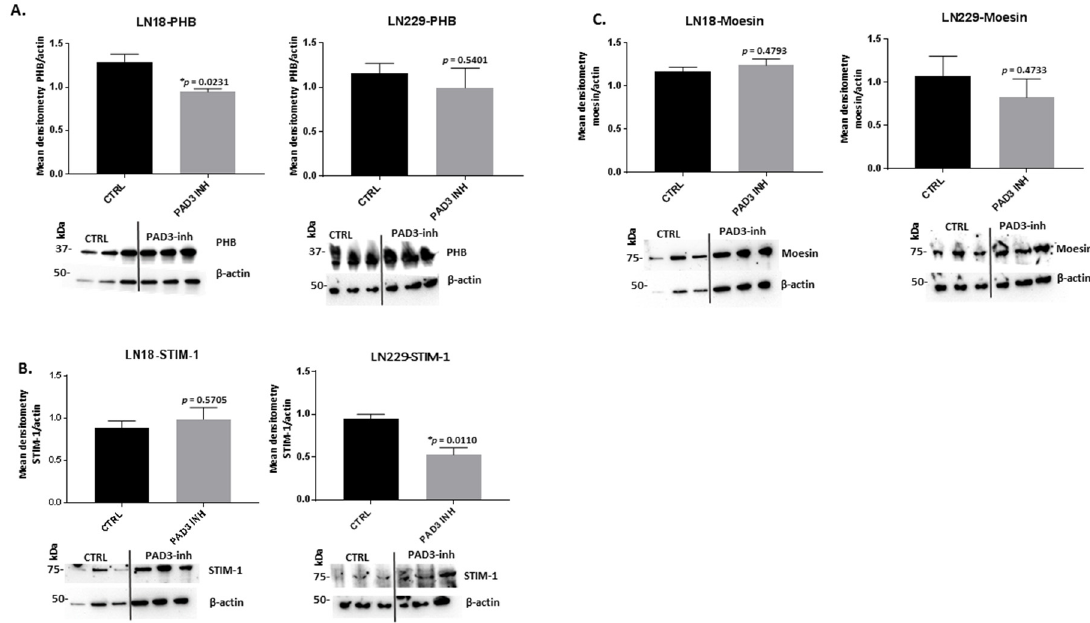
Figure 6. PAD3 isozyme-specific inhibitor 1 h treatment affects PHB, STIM-1 and moesin protein levels in two GBM cell lines. ( A ) PHB protein levels in LN18 and LN229 cells, respectively, following 1 h treatment with the PAD3 inhibitor, compared to control-treated cells. ( B ) STIM-1 protein levels in LN18 and LN229 cells, respectively, following 1 h treatment with the PAD3 inhibitor, compared to control-treated cells. ( C ) Moesin protein levels in LN18 and LN229 cells, respectively, following 1 h treatment with the PAD3 inhibitor, compared to control-treated cells. Representative blots are shown; the density ratios of the various proteins analysed and actin are presented as normalised quantified data (mean ±S.D.) for treatment with the PAD3 specific inhibitor, compared to DMSO treated controls. The corresponding molecular weight size standard is indicated in kilodaltons (kDa) on each blot. Exact p -values are indicated, error bars show SD (* indicates significant differences with p < 0.05; n = 3 biological replicates for all).